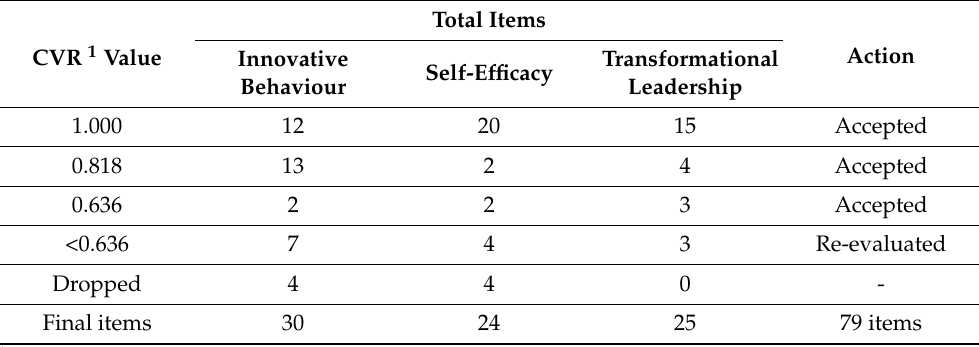
Table 1. Item evaluation for expert